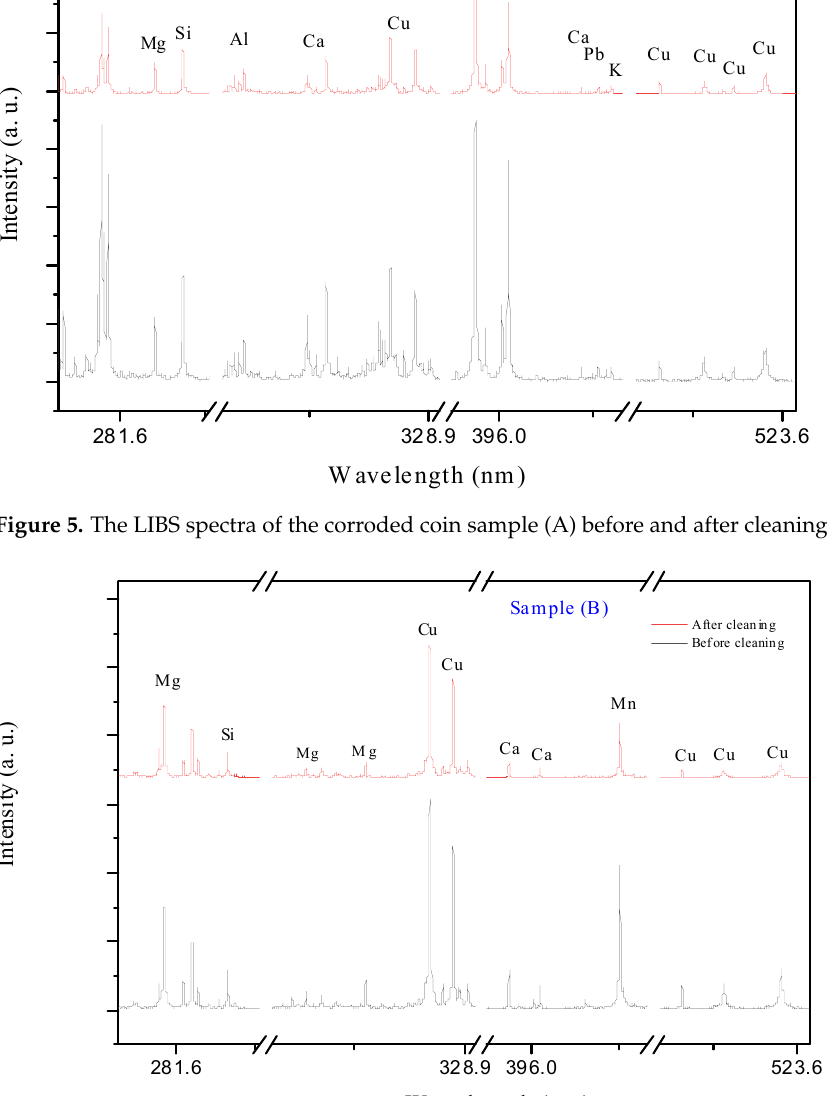
Figure 6. The LIBS spectra of the corroded coin sample (B) before and after cleaning.